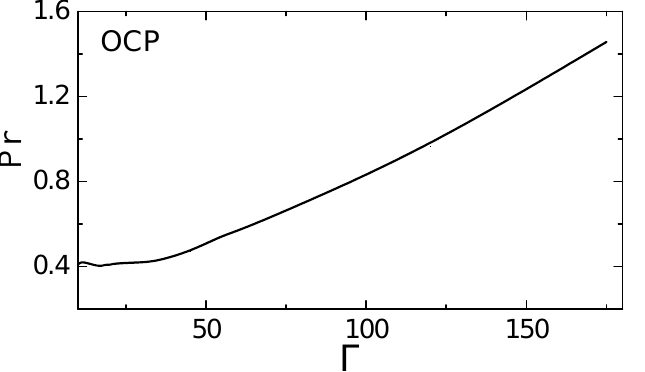
Figure 2. Prandtl number, Pr, of a strongly coupled one-component plasma (OCP) fluid versus the coupling parameter Γ